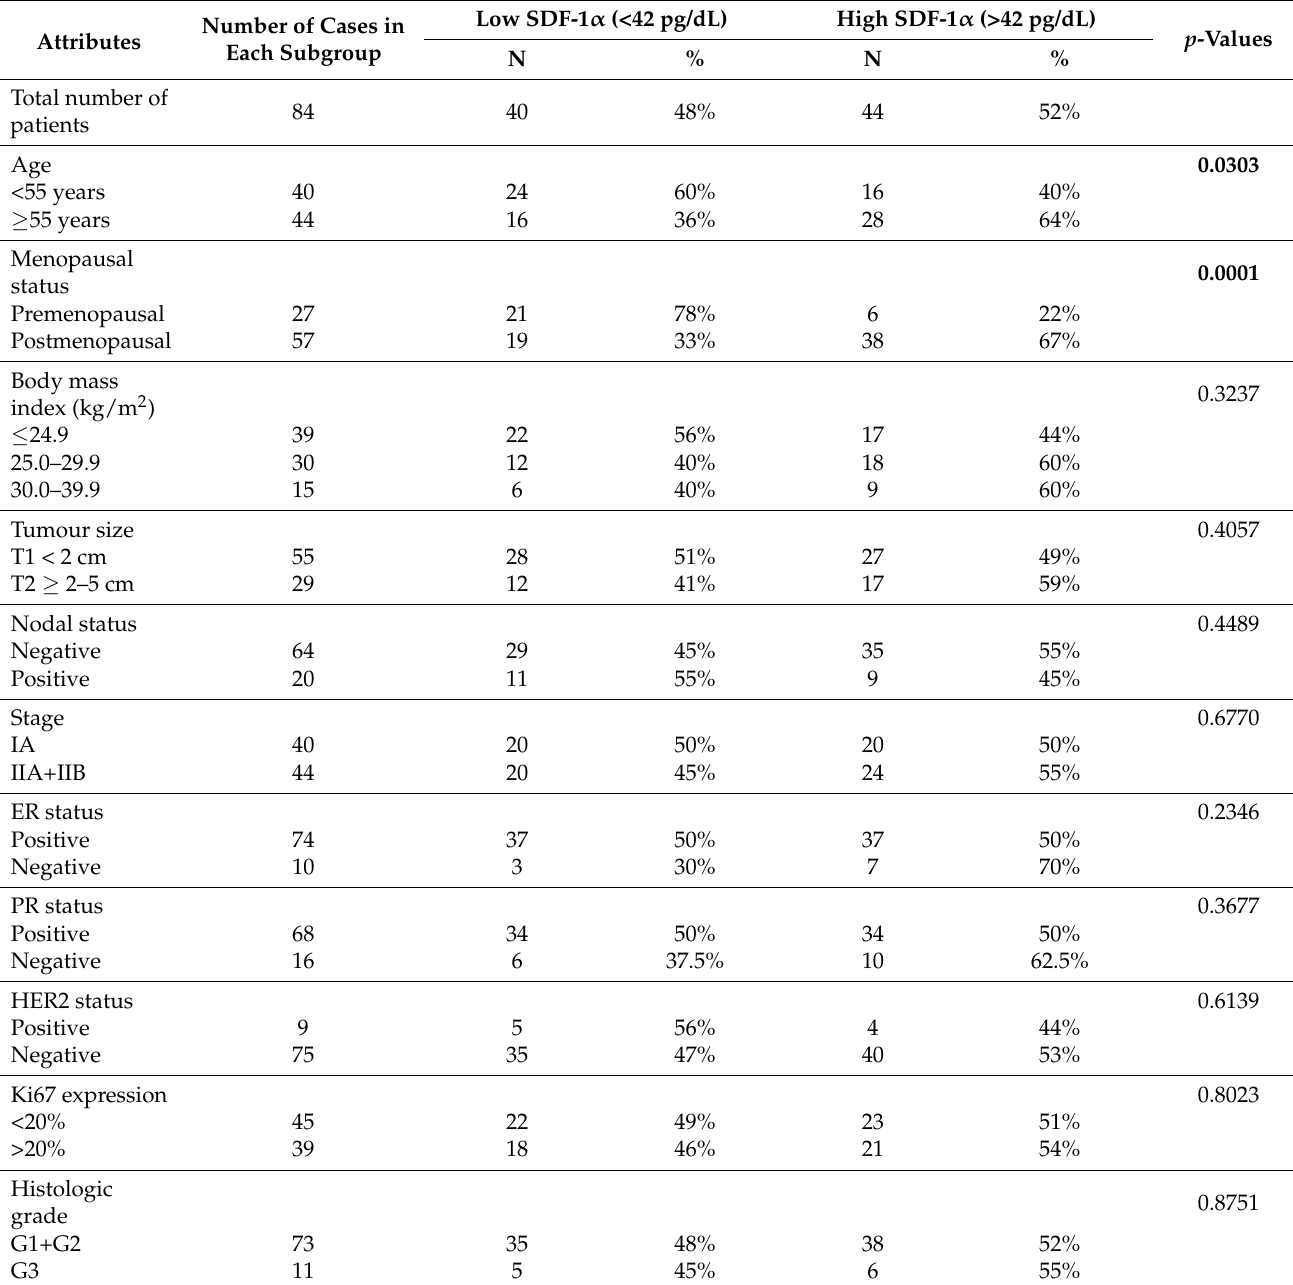
Table 2. Pre-treatment profiles of the study population based on proportion scores with the cut-off value of 42 pg/mL for the immunoassay regarding SDF-1 α